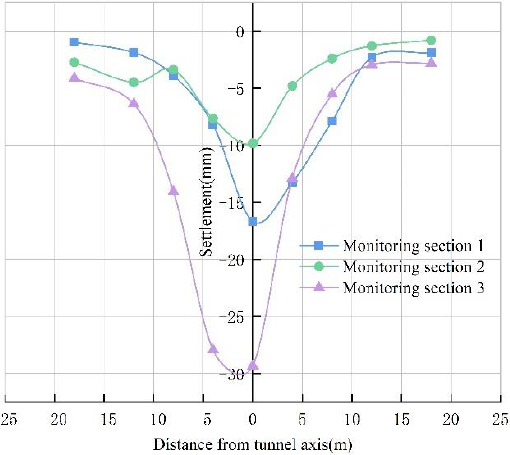
Figure 4. Lateral surface settlement trough caused by tunnel excavation.